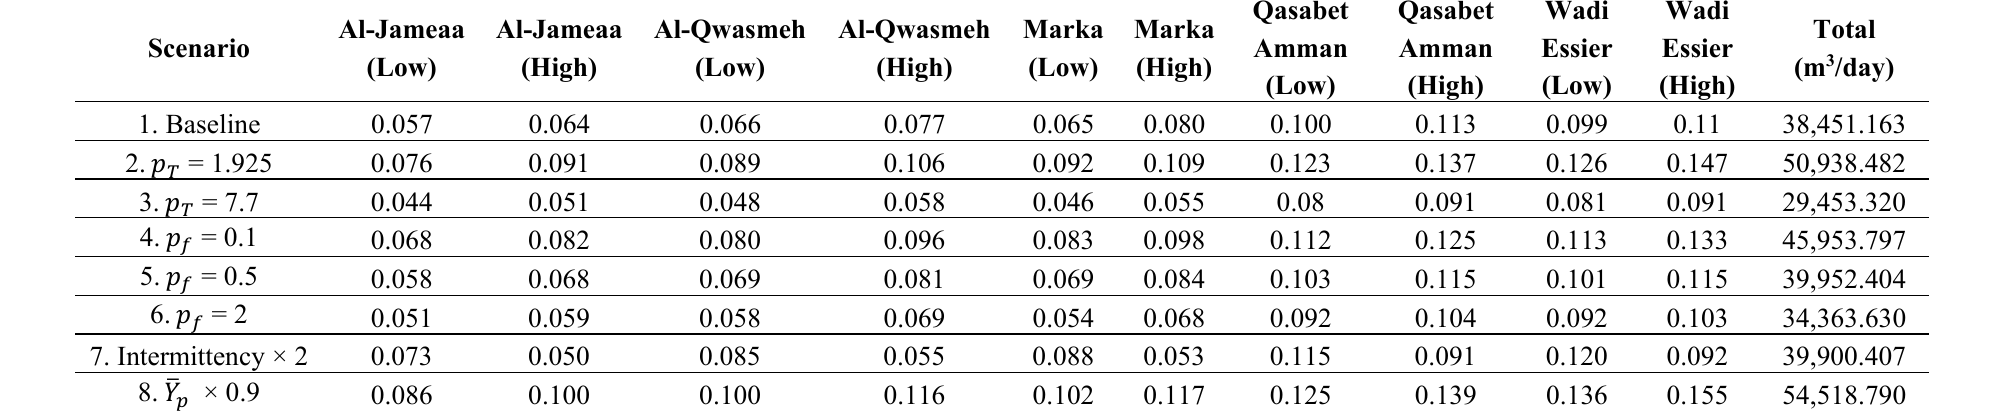
Table 3. Tanker water allocations (m 3 /hhld./day).